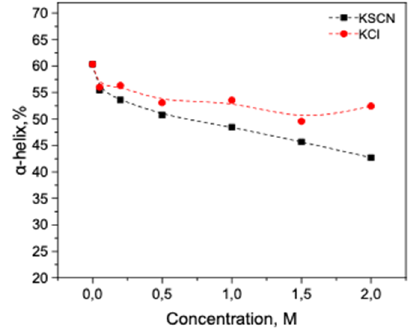
Figure 6. Changes in the second derivative of the Amide I band ( a ) and in secondary structure ( b ) of HSA in 10% wt. aqueous solution at 23 °C with various concentrations of KCl. Figure 7. Salt-specific effects on the α-helical secondary structure of HSA measured by the FTIR spectroscopy.